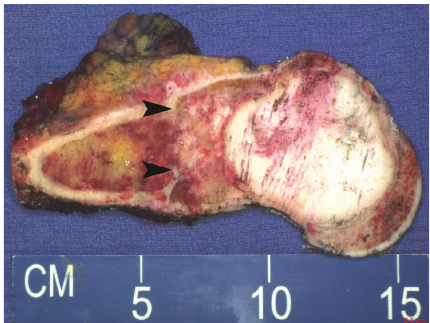
Figure 11: Distal femoral amputation demonstrated an ill-defined mass (arrows) proximal to the PMMA packing.